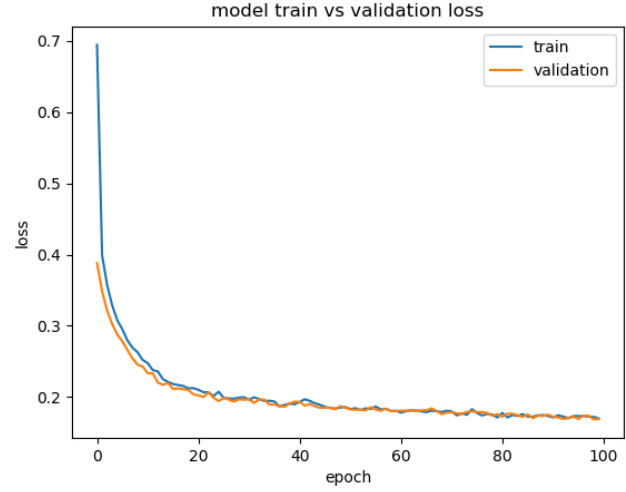
Figure 6. Loss values for training and prediction.